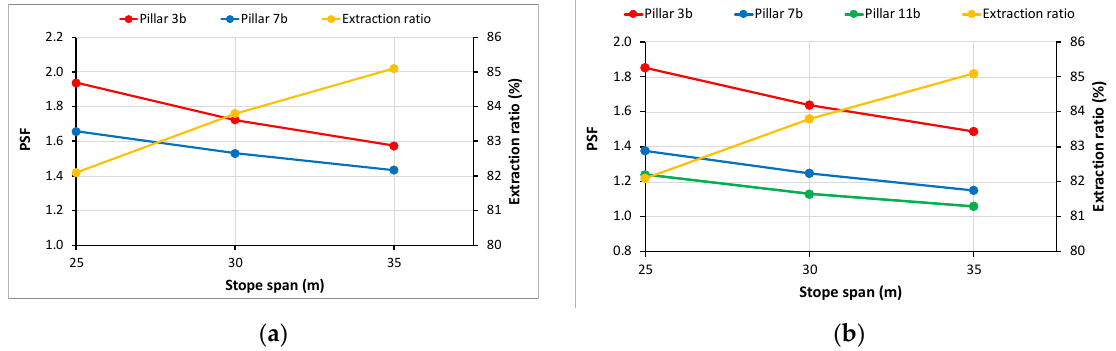
Figure 7. Variation of PSF and extraction ratio with the stope span for the three pillars in ( a ) Block 2 and ( b ) Block 3 mining stage.